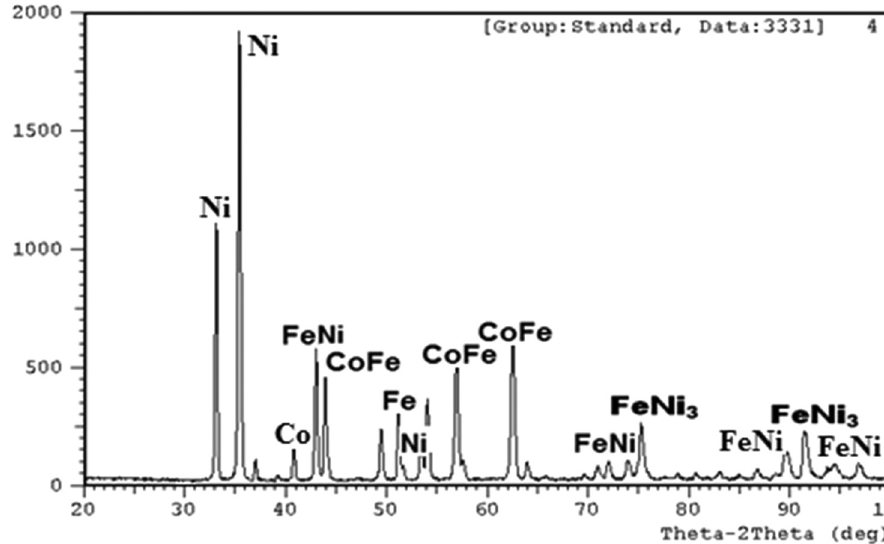
Figure 12: X - ray di ff raction of the ( Fe – 37.5% Co ) 25% Ni specimen at 1,100°C.